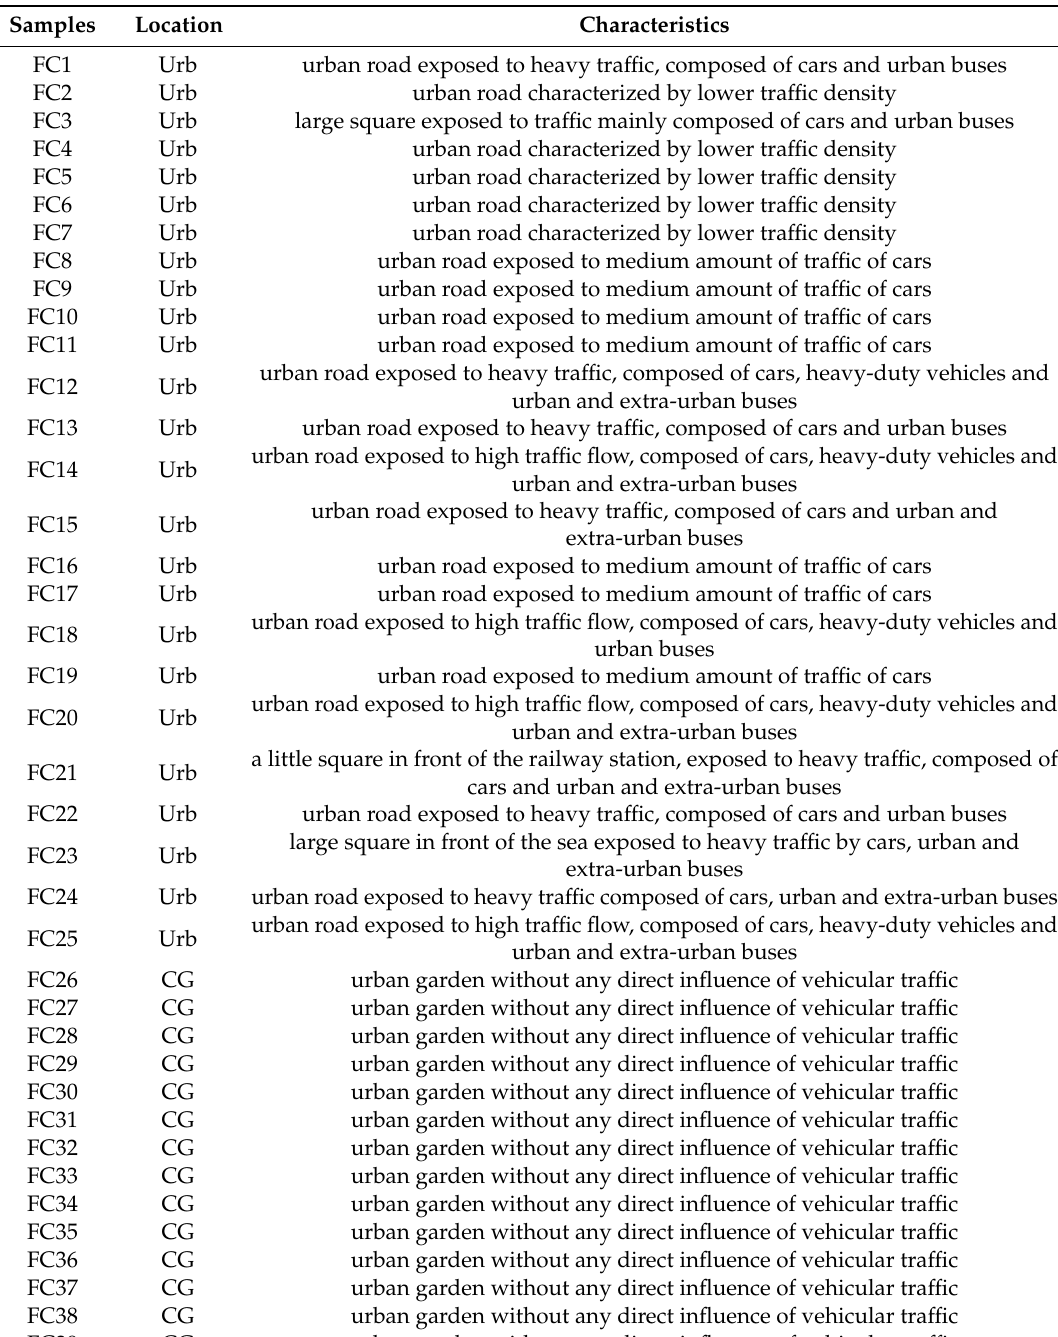
Table 1. Sampling sites and location descriptions. Legend: Urb, samples collected from the long main urban road; CG, samples collected from city